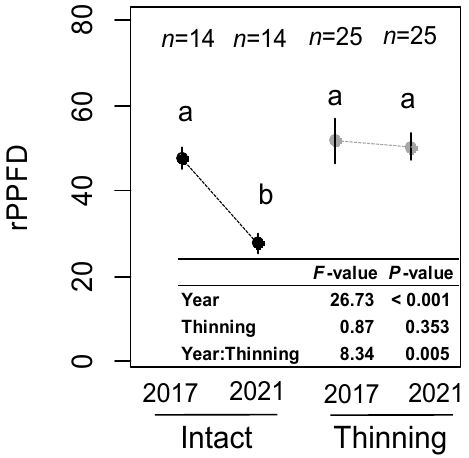
Figure 1. Changes in mean relative photosynthetic photon flux density (rPPFD %) values ( ± SE) in the intact and thinning classes within the seed orchard from 2017 to 2021. Different letters show statistical significances.